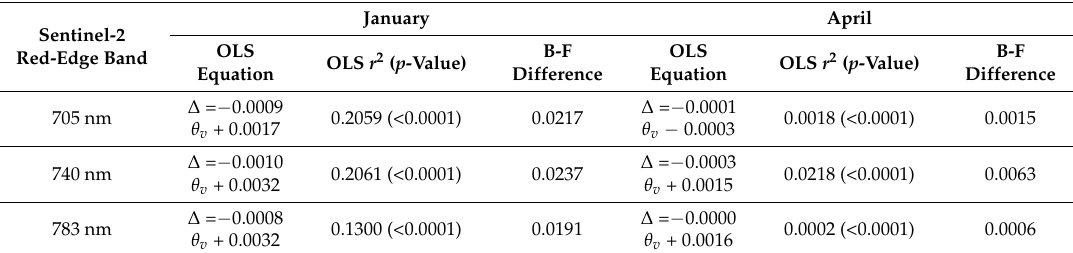
Table 6. Summary of the ordinary least squares (OLS) linear regressions of the surface NBAR differences illustrated in Figures 6 and 7; OLS regression coefficient of determination ( r 2 ), the OLS regression F-test p -value, and the B-F difference. A total of 6,600,685 and 10,656,197 pairs of forward and back scatter surface reflectance values were considered in January and April,